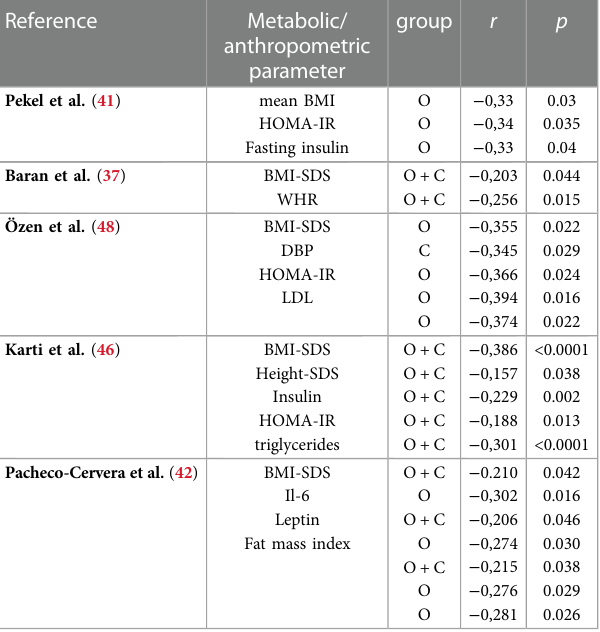
TABLE 3 Reported signi fi cant correlation between RNFL and anthropometric and metabolic parameters in literature.